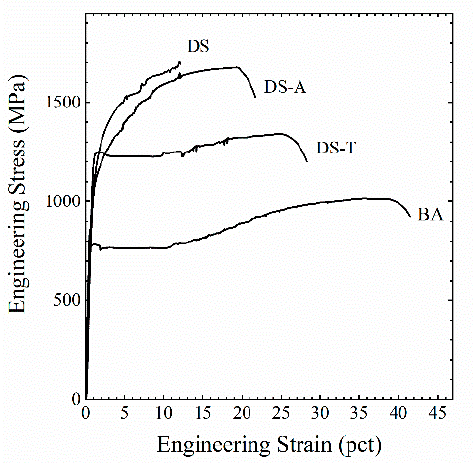
Figure 4. Tensile properties of a 7.14 Mn, 0.14 C (wt. pct.) steel after intercritical batch annealing (BA) first soak, after double soaking (DS) with a second soak of 30 s at 800 °C, and after double soaking, cooling to room temperature and tempering for 300 s at 450 °C (DS-T), and after double soaking followed by austempering for 300 s at 450 °C (DS-A) [11].